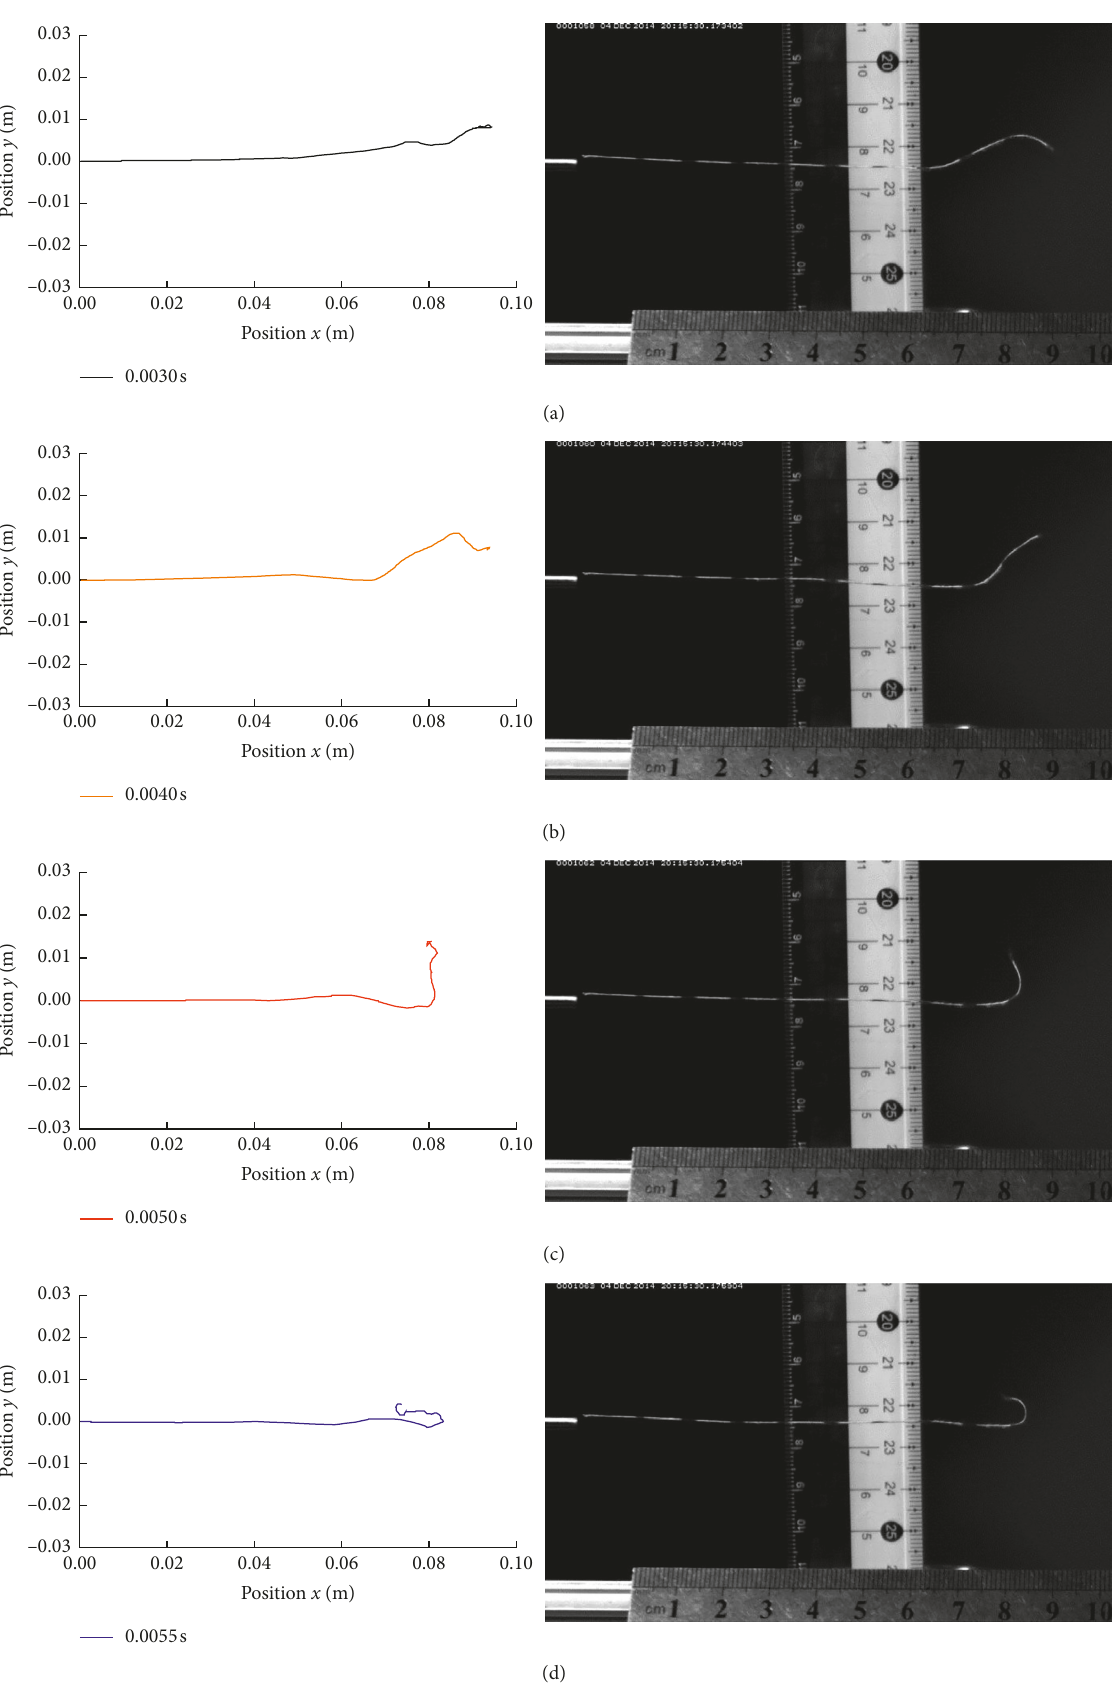
Figure 6: Result comparison of fiber between numerical simulation and high-speed